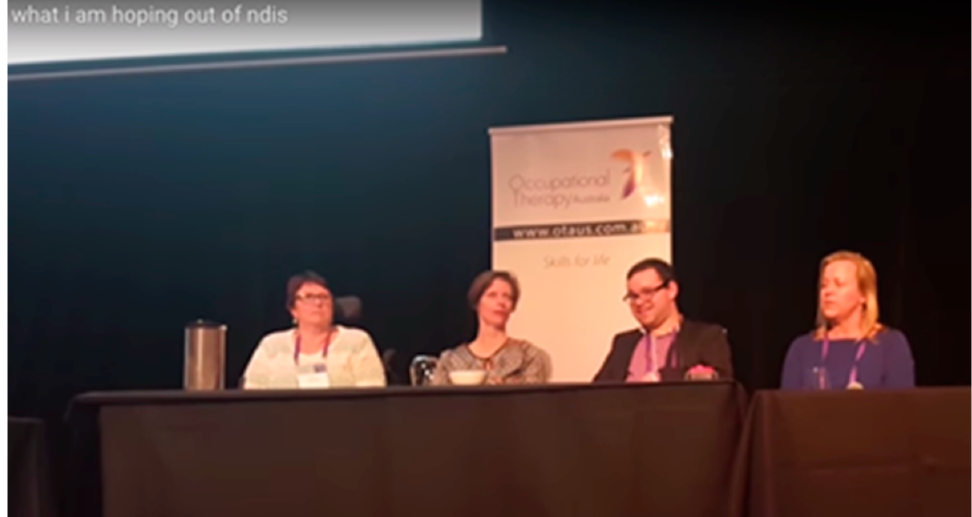
Figure 1. Co-presenting [left to right] colleague LF (Acknowledging our colleague L.F.), and authors NL, JB, and LC at Occupational Therapy Australia—Victoria conference panel. Source: Personal photo of author